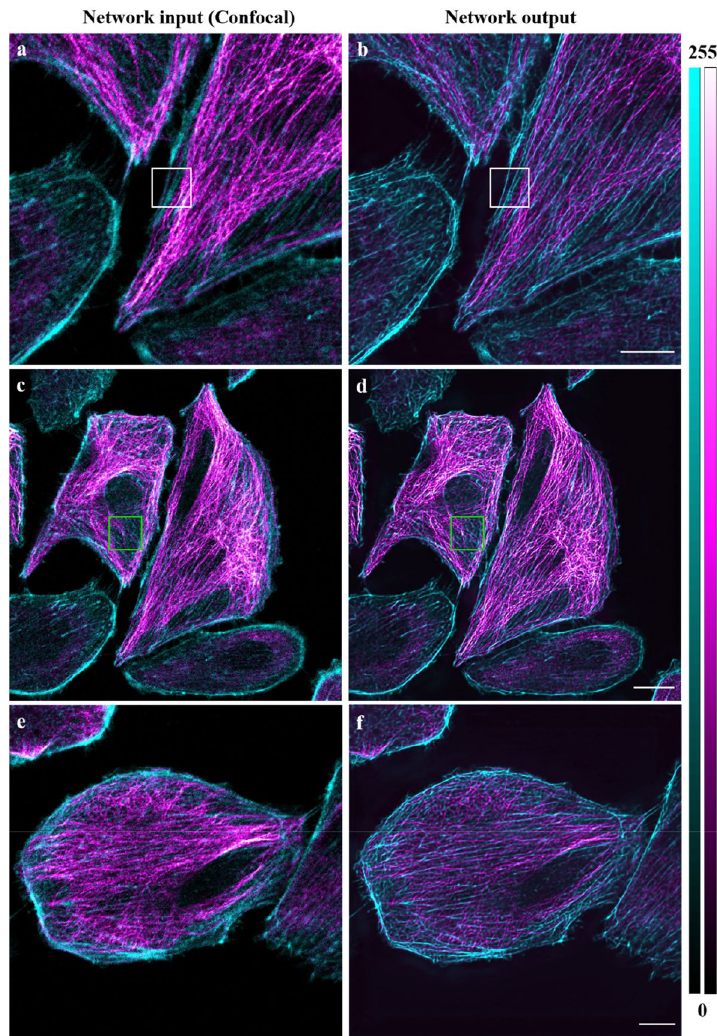
Fig. 10 Super-resolution imaging of dual-color actin-microtubules using TCAN. ( a , c , e ) Dual-color confocal microscopy images of the microtubules (magenta) and the filaments (cyan) are used as input to the network. ( b , d , f ) The super-resolved output images of the same field of view. Scale bars in ( b ), ( d ) and ( f ) are 10 μm, 10 μm and 15 μm,